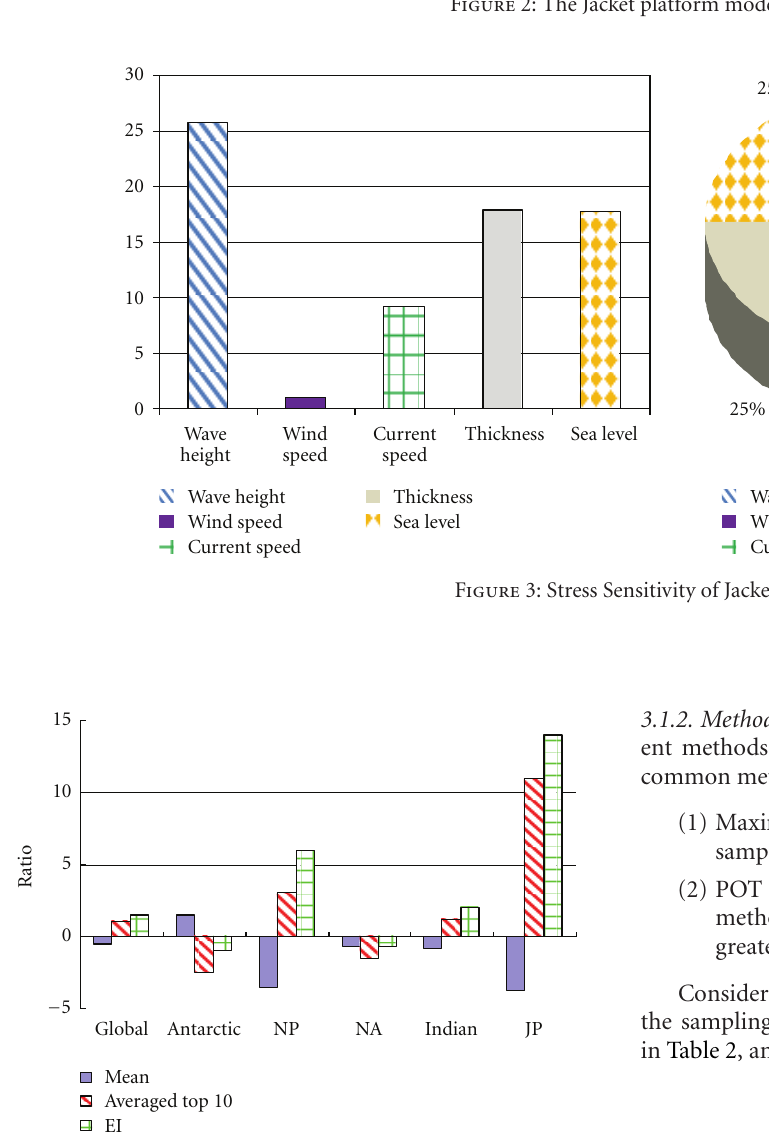
Figure 4: Spatially averaged mean, top 10 and EI of Hs (NP: Northern Pacific, NA: Northern Atlantic, JP: Pacific Ocean near